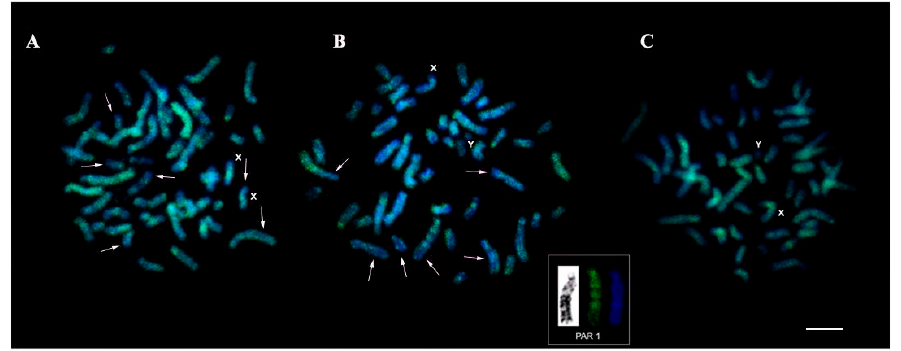
Figure 5. Chromosomal mapping of the transposable element LINE-1: ( A ) T. inunguis ; ( B ) T. m. manatus ; the insert indicates the pair 1 chromosome with a LINE-1 pattern similar to bands and compared to the pattern of G bands; and ( C ) “Poque”. Arrows indicate chromosomal regions in TIN and TMM karyotypes with low LINE-1 concentration. Bar 10 μ m.